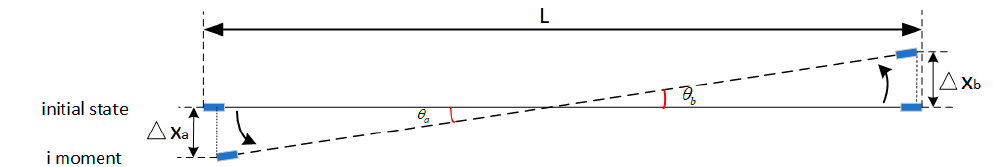
2 arcsin 2 arcsin